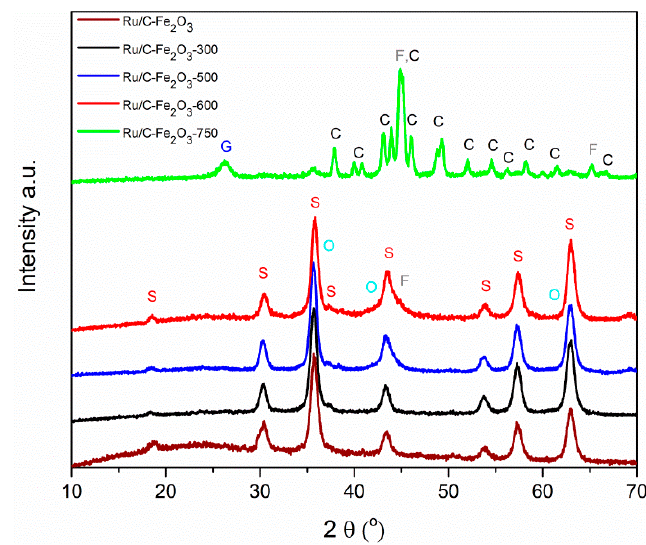
Figure 1. XRD patterns of catalysts. S corresponds to reflections of cubic spinel-iron oxide, F of BCC iron, O of wustite, C of cohenite, and G of